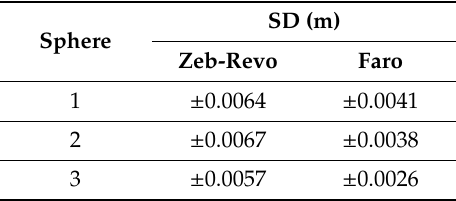
Table 2. Standard deviation of the RANSAC-based sphere fitting to align both datasets in a global CRS